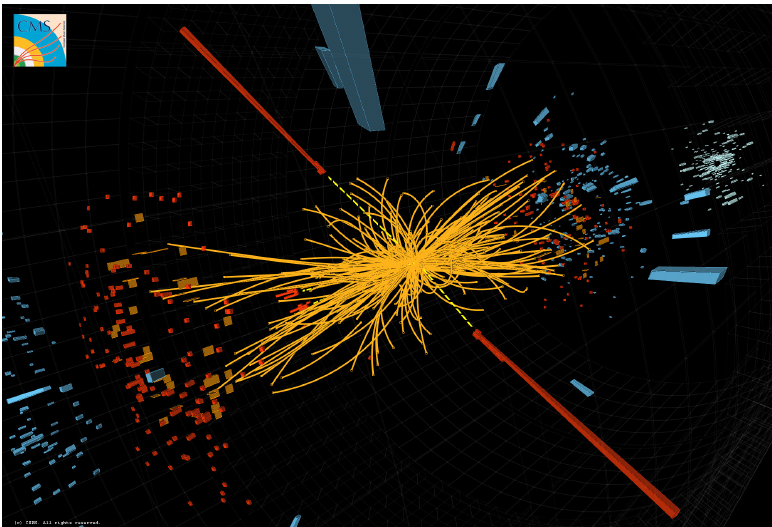
Figure 5. A CMS event: H → γγ candidate. The size of the orange boxes is proportional to the energies deposited in the electromagnetic calorimeter by the neutral photons of invisible tracks. Note the huge hadron background from proton-proton collisions.